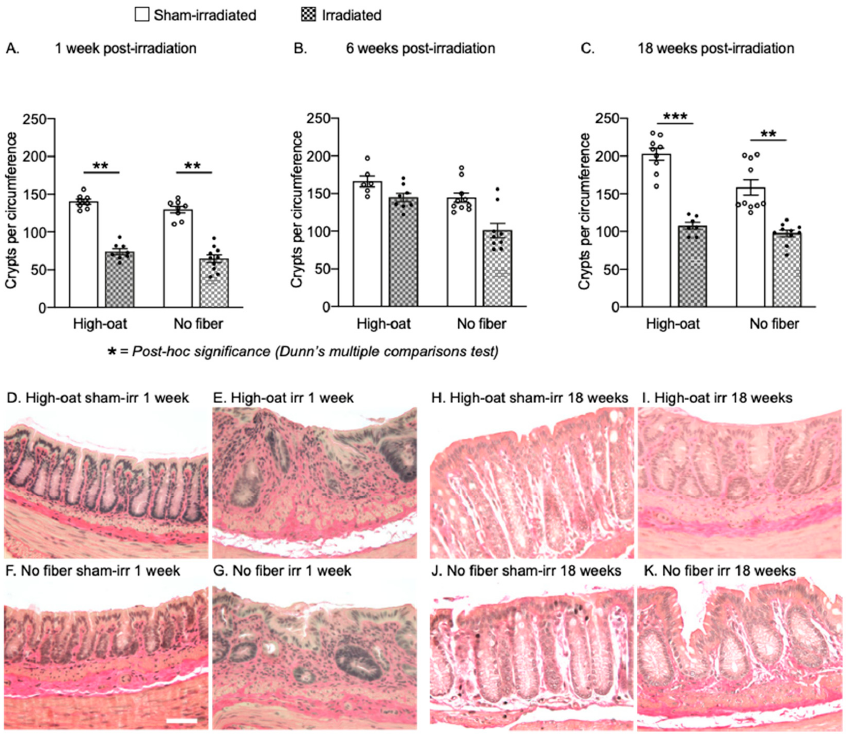
Figure 5. Crypts per circumference over time after irradiation. ( A ). A decrease in the number of crypts per circumference was seen in the High-oat and the No-fiber mice compared to the sham-irradiated mice at one week. ** p = 0.0025 and ** p = 0.0017. ( B ). At six weeks, the High-oat irradiated animals appeared to have more crypts compared to the No-fiber irradiated mice ( p = 0.0771). ( C ). At 18 weeks, both the High-oat and the No-fiber irradiated animals had similar numbers of crypts. *** p = 0.0008 and ** p = 0.0025. ( D – K ). Representative micrographs (40× magnification, Verhoeff’s Elastic Stain) of crypts in the colorectal mucosa. Data are shown as mean ± S.E.M. Bacteria were quantified in the mucosa and submucosa at the acute time point (1 week post-irradiation) and the late time point (18 weeks post-irradiation). There were no differences in bacterial infiltration between the groups at 1 week post-irradiation (Figure 6A). At 18 weeks, there was a profound increase in bacterial infiltration in the No-fiber